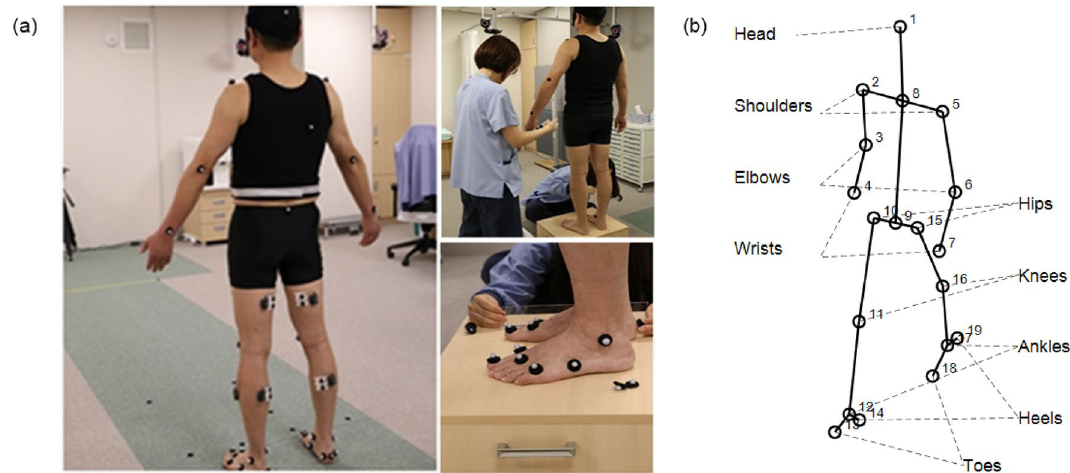
Figure 1. (a) Using Helen Hayes Marker set to capture the motion during walking trials. (b) Seventeen anatomical points were extracted from the motion capture data. Sixteen body segments (solid line) were defined by connecting the anatomical points.